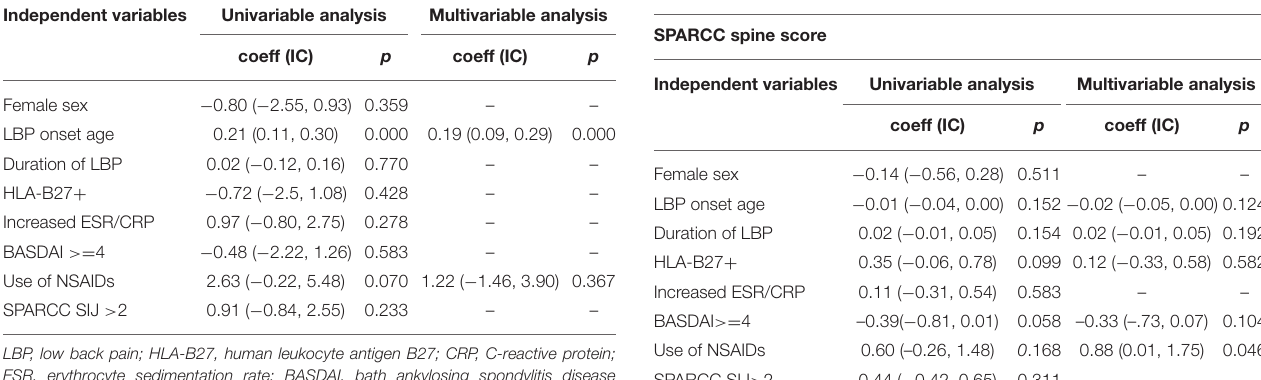
TABLE 5 | Baseline predictors factors of SPARCC spine score and SPARCC SSJ score at T24. SPARCC spine score